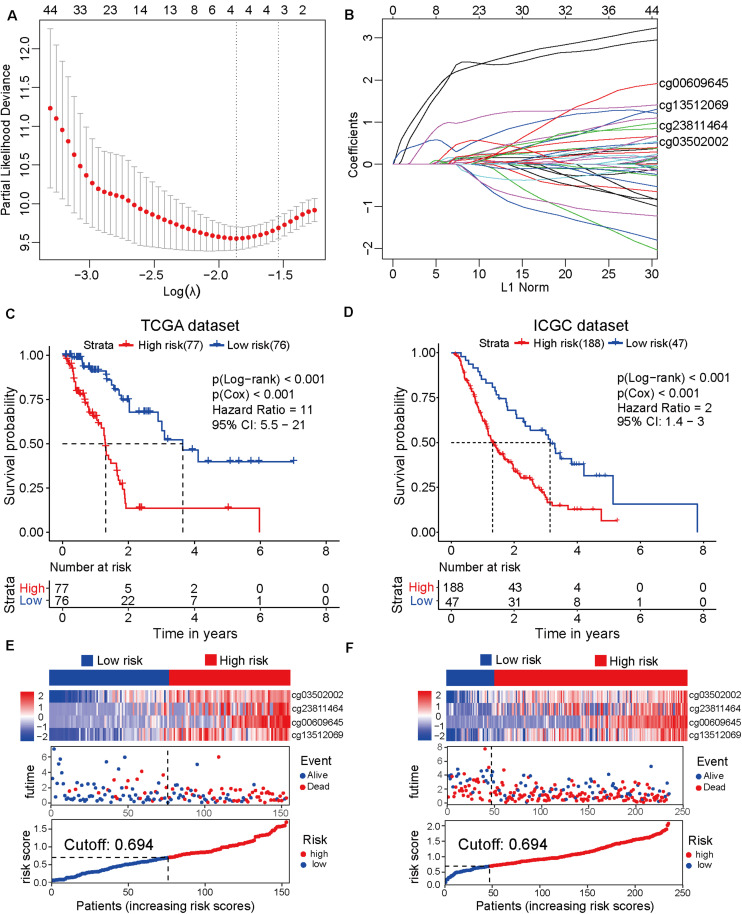
Development and verification of the prognostic prediction model based on four CpG sites by least absolute shrinkage and selection operator (LASSO) regression. (A) The selection of tuning parameter (λ) in the LASSO model based on the 10–fold cross–validation with minimum criteria. The log(λ) value of -1.863678 is used for further analysis. (B) The four CpG sites (cg00609645, cg13512069, cg23811464, and cg03502002) and their coefficients were used to construct the model. (C) The Cancer Genome Atlas (TCGA) dataset (discovery cohort) is divided into high-risk (N = 77) and low-risk (N = 76) groups based on the risk scores generated from the LASSO model. The Kaplan-Meier survival plots of high-risk and low-risk groups. (D) The Kaplan-Meier survival plot of the high-risk (N = 188) and low-risk (N = 47) groups of the International Cancer Genome Consortium (ICGC) dataset (validation cohort). (E) From top to bottom, the heatmap of the four CpG sites in the high-risk and low-risk groups of TCGA dataset (top). The distribution plot of survival time and survival status of high-risk and low-risk groups of TCGA dataset (middle). The X-axis is the patients’ number with increasing risk scores and the Y-axis is the survival time. The distribution plot of the risk scores of the high-risk and low-risk groups of TCGA dataset (bottom). (F) The heatmap of the four CpG sites of the high-risk and low-risk groups of the ICGC dataset (top). The distribution plot of survival time and survival status of the high-risk and low-risk groups of the ICGC dataset (middle). The distribution plot of the risk scores of the high-risk and low-risk groups of the ICGC dataset (bottom).